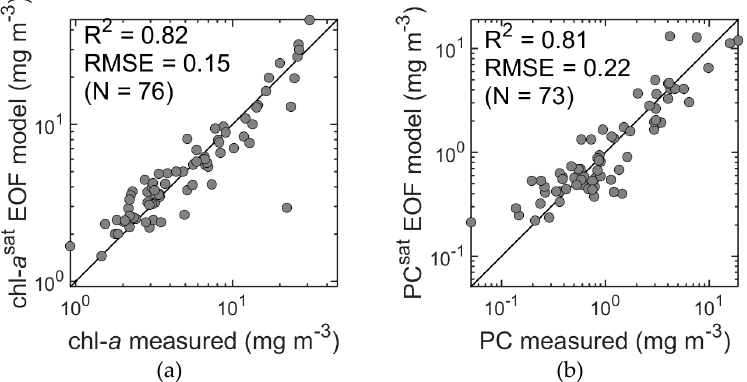
Figure 14. Comparison between chl- a ( a ) and PC ( b ) measured in situ and received from the EOF model for reduced spectral resolution.